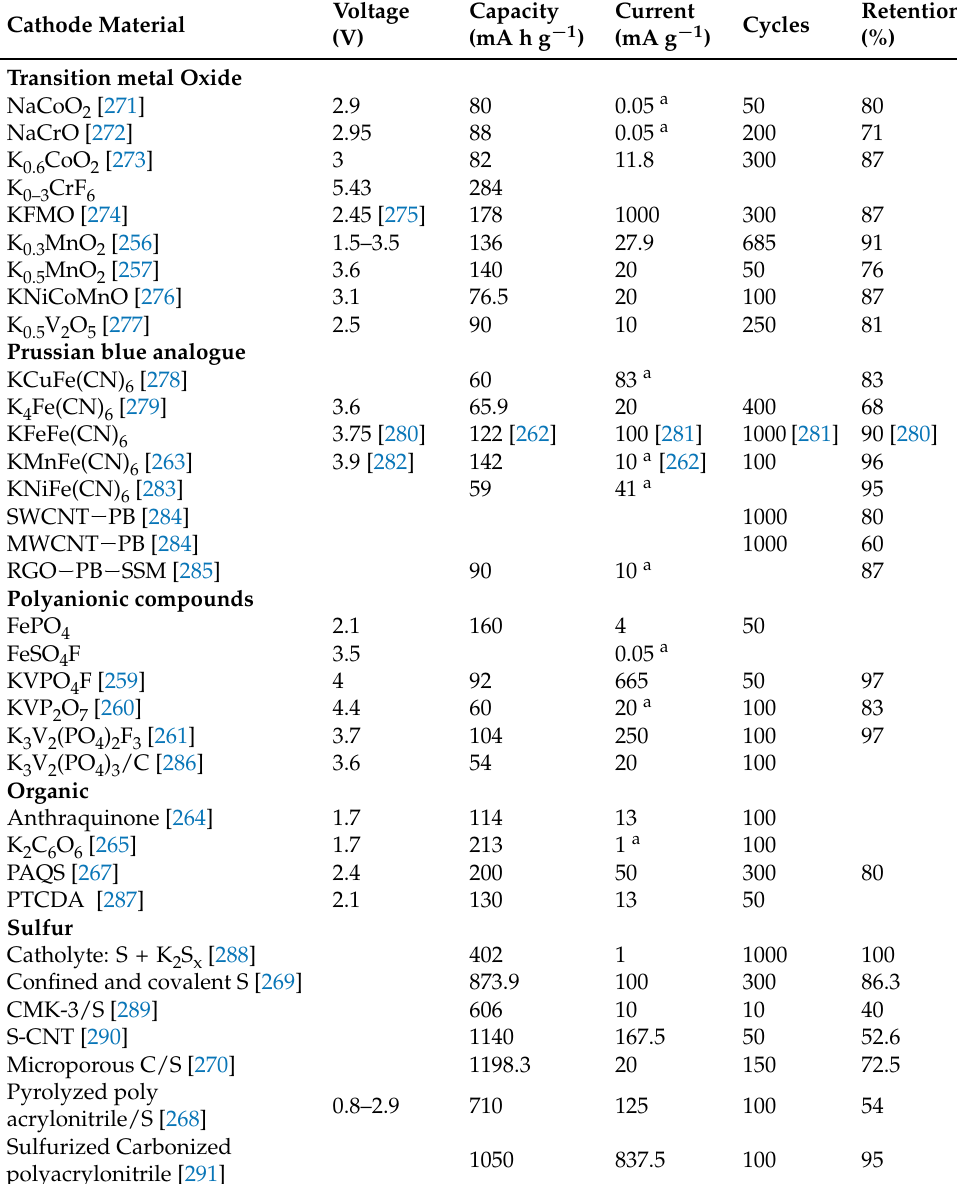
Table 10. Cathode materials for K-based